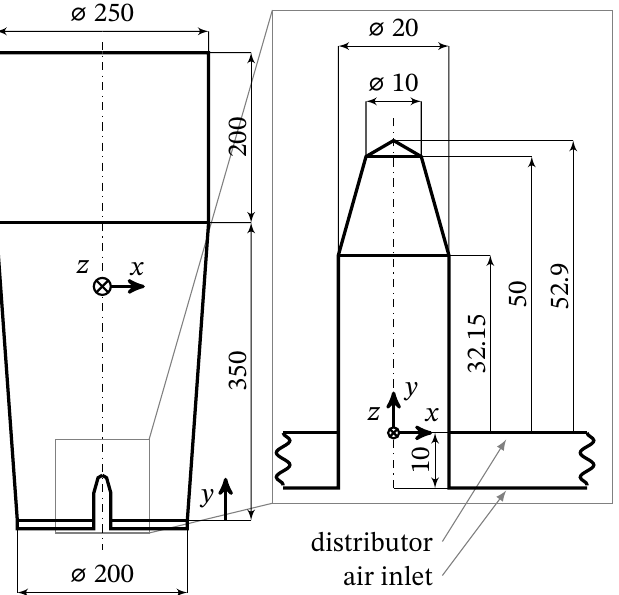
Figure 2. Dimensions of the lab-scale granulator (Glatt GF3) model in mm. A solution of 30 wt% sodium benzoate in distilled water was injected into the process chamber using a peristaltic pump connected to a Schlick 970 S3 two-fluid nozzle (opening diameter 1.2 mm), which was installed in bottom-spray configuration. The atomization air was supplied from the in-house pressure lines and fed through a preheater into the two-fluid